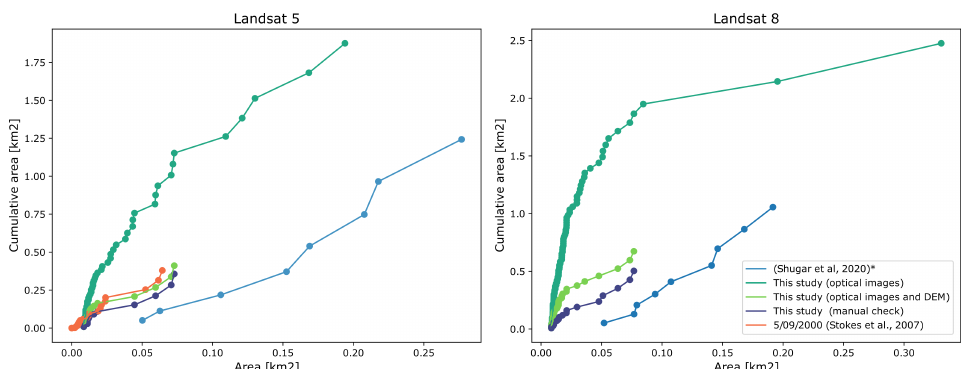
Figure 5. The cumulative area of the lakes of different sizes, detected with different methods, suggested in this study, compared with existing glacial lake inventories in Central Caucasus. * Note, the Shugar et al. (2020) study contains substantial misclassifications in the